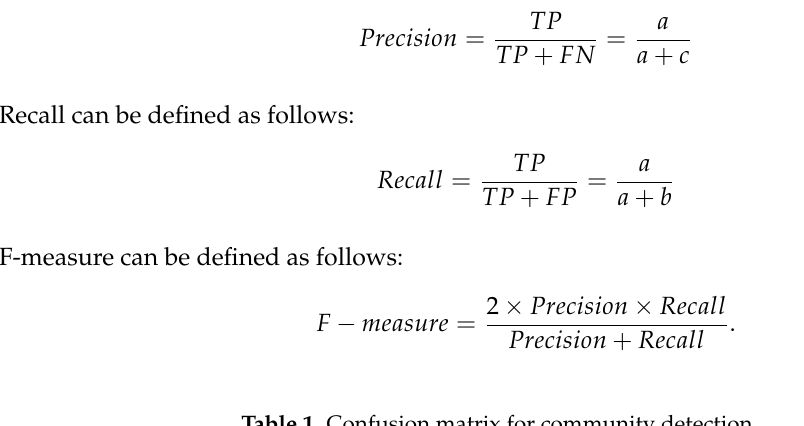
Table 1. Confusion matrix for community detection.